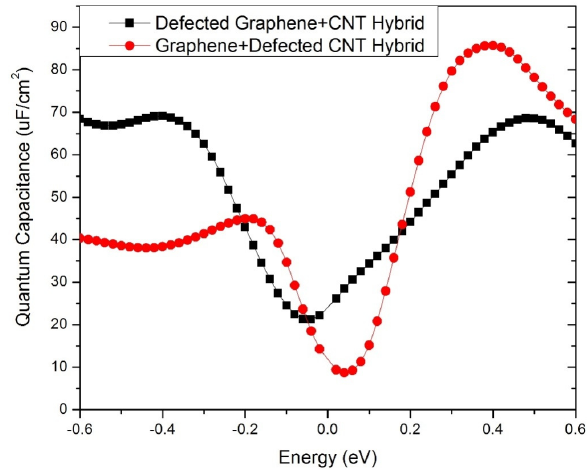
Figure 8. Quantum capacitance (C Q ) of the defective graphene + pristine CNT hybrid and the pris- tine graphene + defective CNT hybrid electrodes. Electrochemical Performance